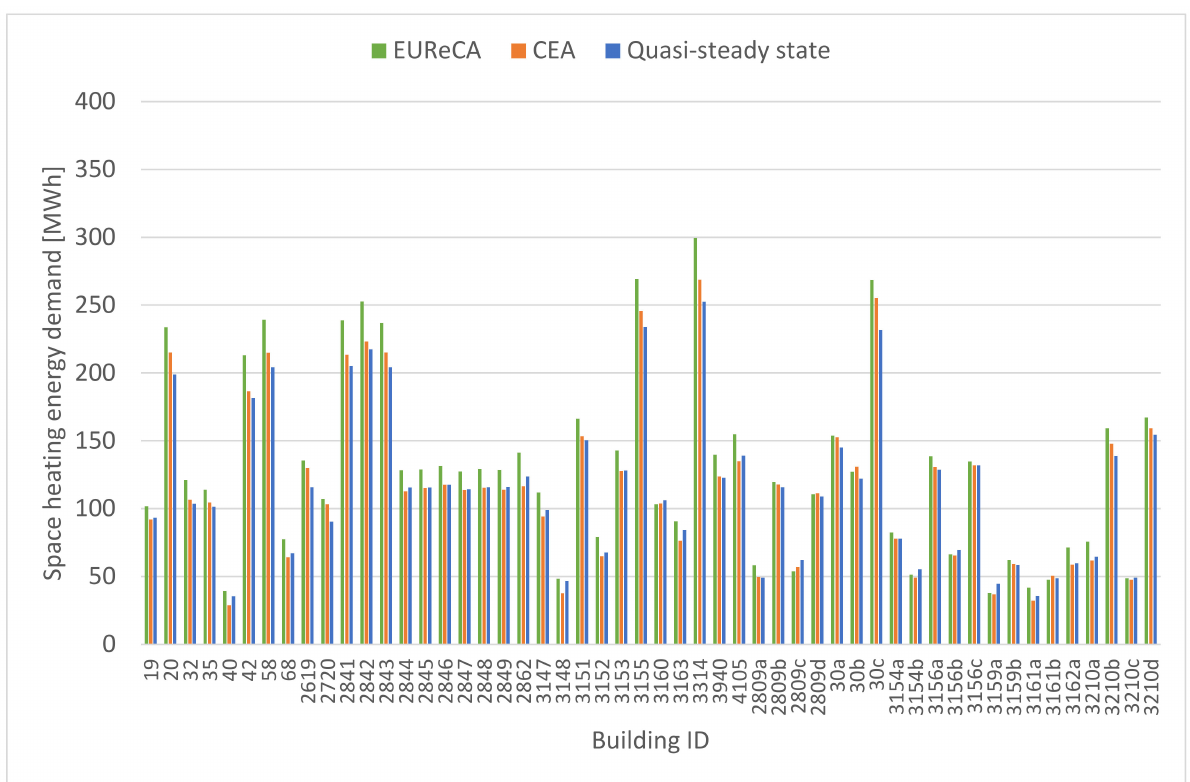
Figure 5. Estimation of the space heating energy demand in the heating period due to envelope transmission losses.